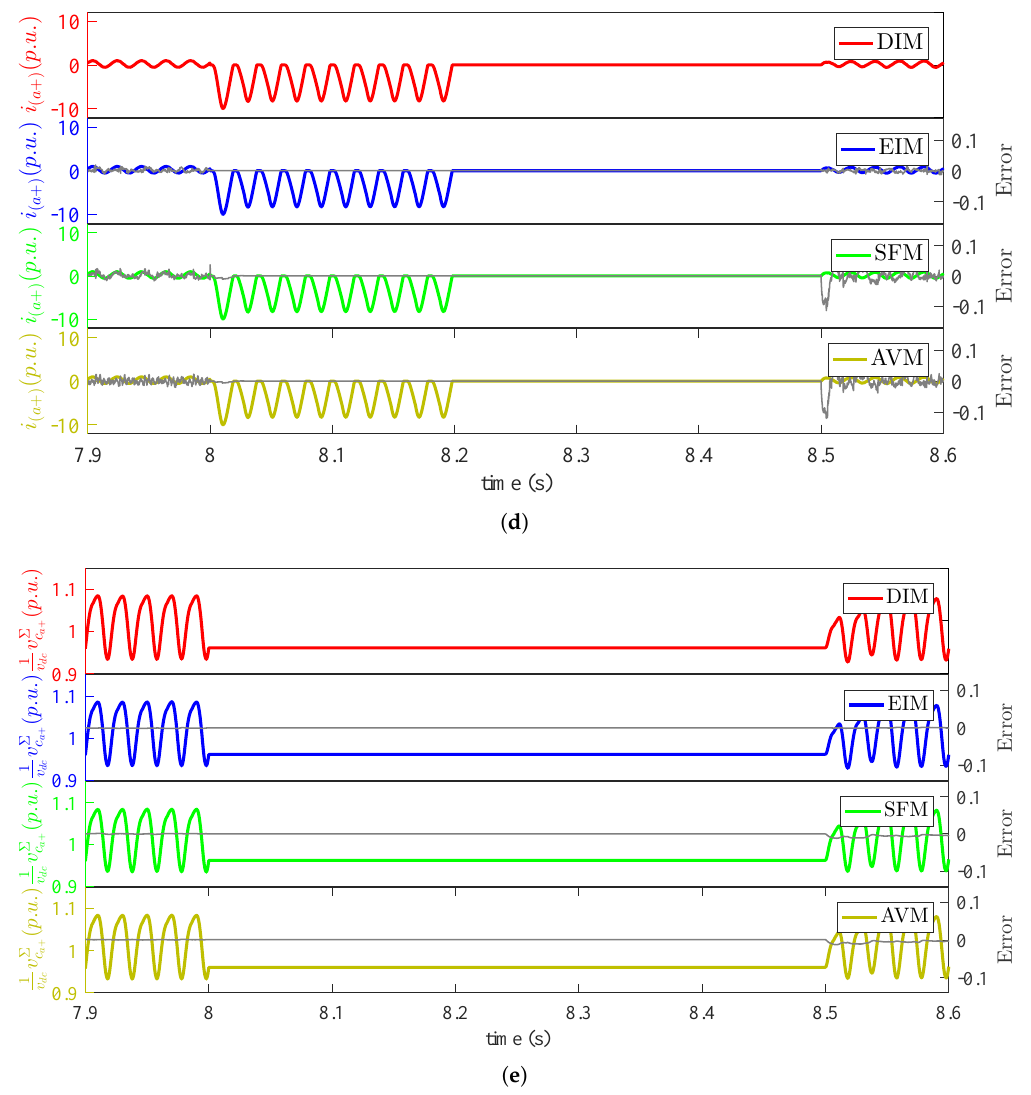
Figure 12. Pole-pole DC fault. ( a ) AC voltage v ac model error; ( c ) DC current i dc andthemodelerror; ( d ) positive arm current i ( a +)